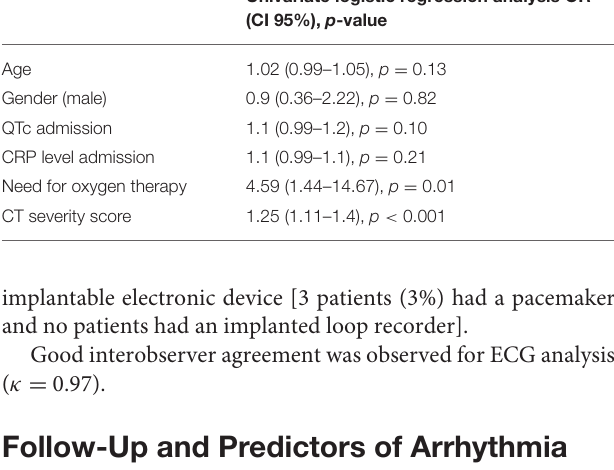
TABLE 2 | Univariate logistic regression analysis for primary endpoint of any arrhythmia